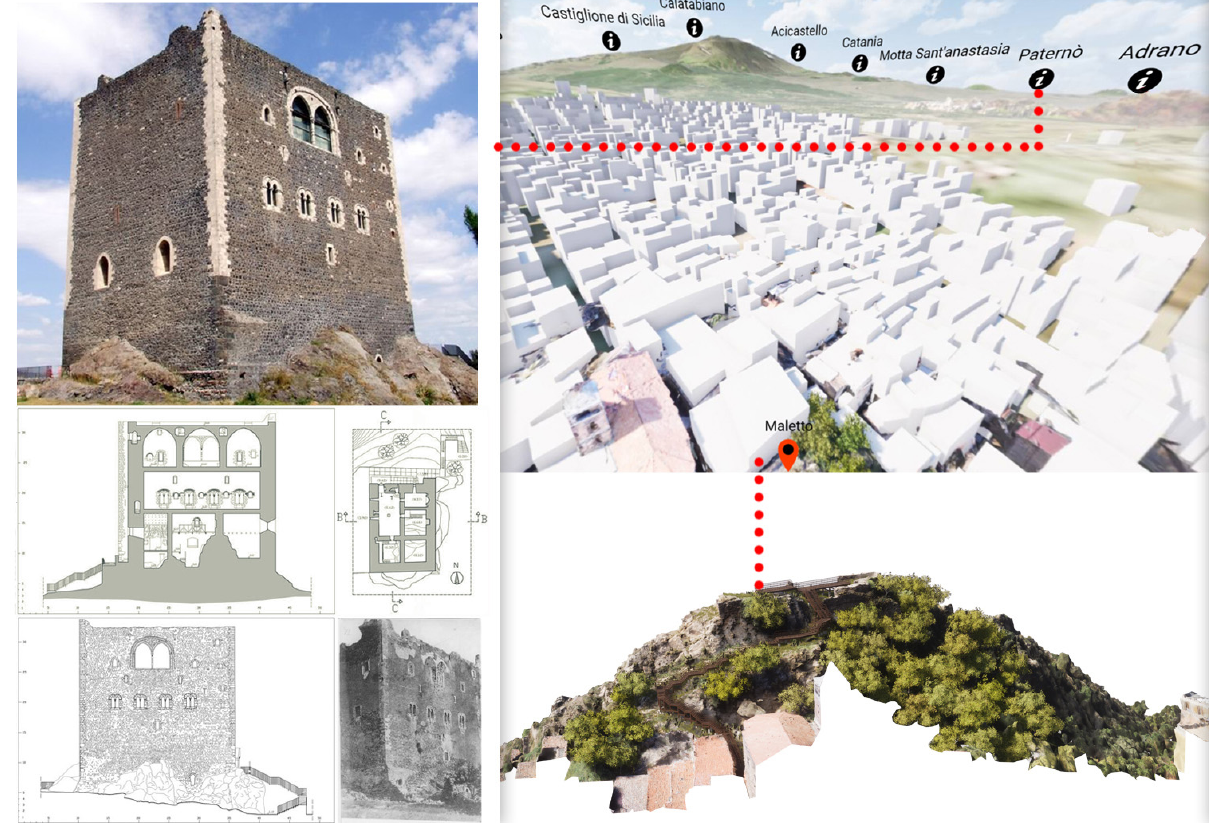
Figure 5. Maletto Castle and the other fortifications of the Etna Route. Smart navigation and interactive query of the 3D